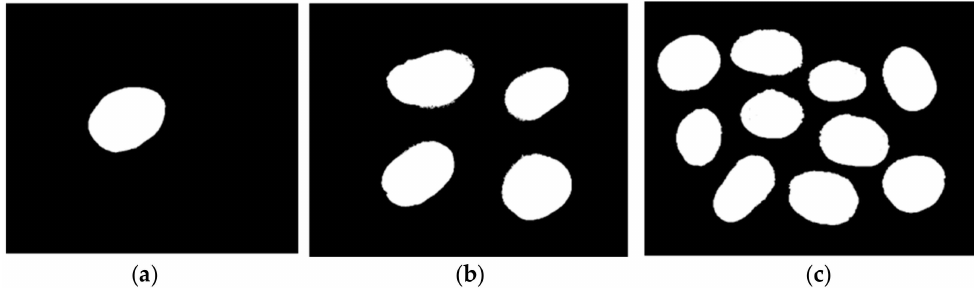
Figure 7. Examples of images segmented for ( a ) one co ff ee bean, ( b ) four co ff ee beans and ( c ) ten co ff ee